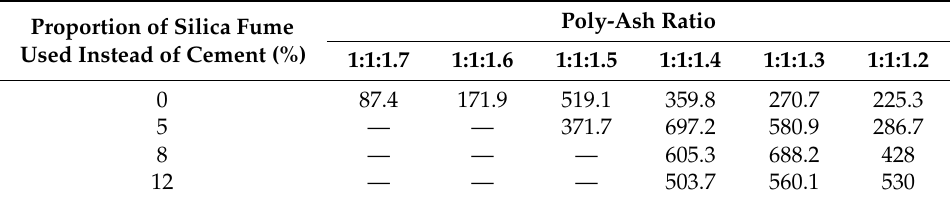
Table 6. Sensitivity coefficient under different ratios of polymer to silica